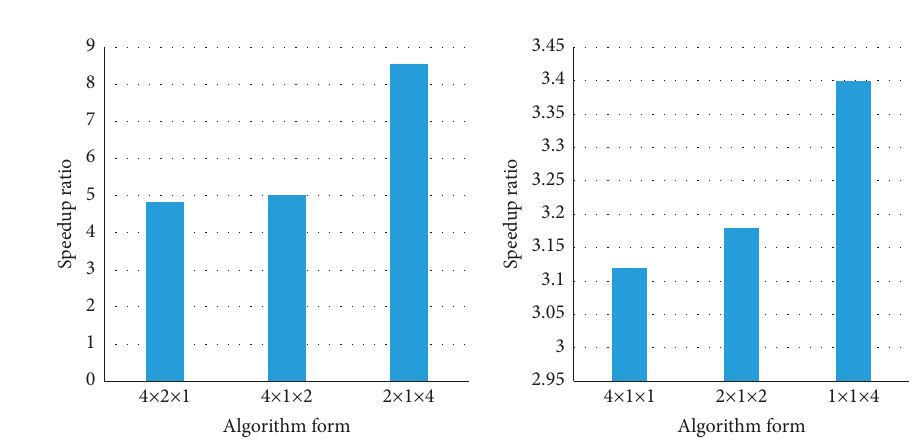
Figure 8: Scalability test